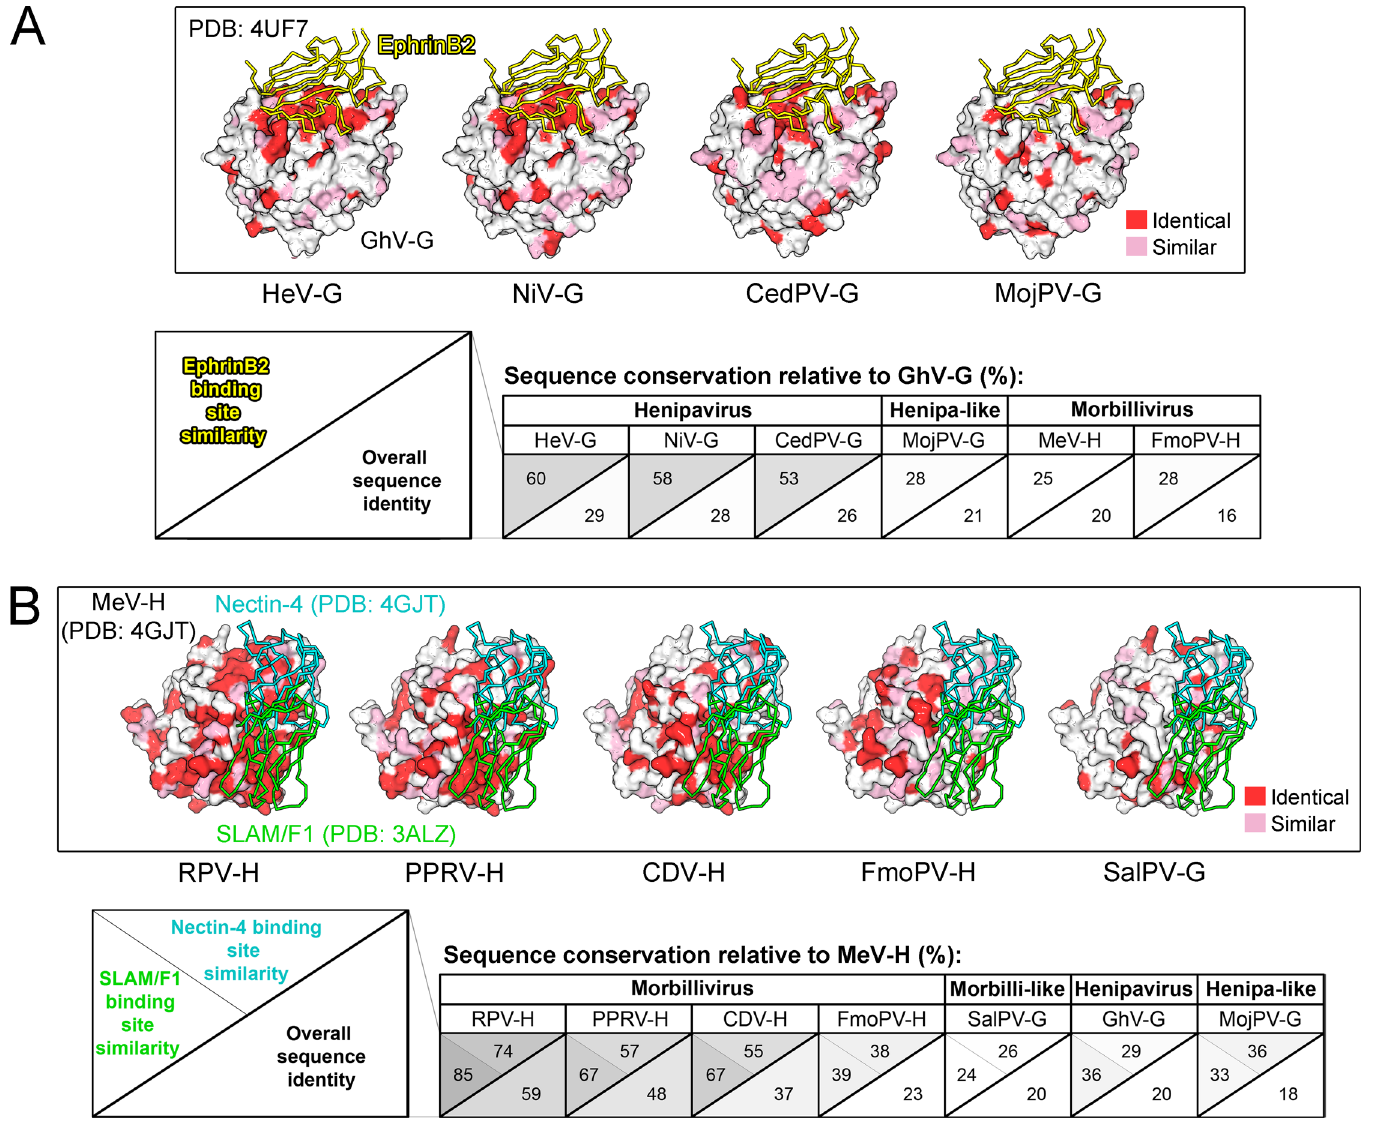
Fig 2. Mapping sequence conservation onto henipavirus and morbillivirus attachment glycoproteins. (A) Crystal structure of Ghanaian bat henipavirus attachment glycoprotein (GhV-G, PDB [Protein Data Bank] ID 4UF7) in complex with ephrinB2. EphrinB2 is shown as a yellow ribbon and GhV-G is shown in surface representation and colored according to sequence conservation with (left to right) HeV-G, NiV-G, CedPV-G, and MojPV-G. Sequence identical residues are colored red and similar residues pink. At the bottom of the panel are tables summarizing overall glycoprotein sequence identity (bottom right) and sequence similarity at the ephrin receptor-binding site (top left), with respect to GhV-G. (B) Crystal structure of measles virus hemagglutinin (MeV-H) in complex with nectin-4 cell surface receptor (PDB ID 4GJT), with the position of SLAM/F1 (green ribbon) receptor-binding shown (based upon structural overlay with the MeV-H-SLAM/F1 crystal structure; PDB ID 3ALZ). Nectin-4 and SLAM/F1 are shown as cyan and green ribbons, respectively. MeV-H is shown in surface representation and colored according to sequence conservation, as in panel A, with RPV-H, PPRV-H, CDV-H, FmoPV-H, and SalPV-G (left to right). At the bottom of the panel are tables summarizing overall glycoprotein sequence identity (bottom right) and sequence similarity at the nectin-4 – (top) and SLAM/F1-binding sites (left), with respect to MeV-H. The tables are color-coded from dark gray (highly conserved) to white